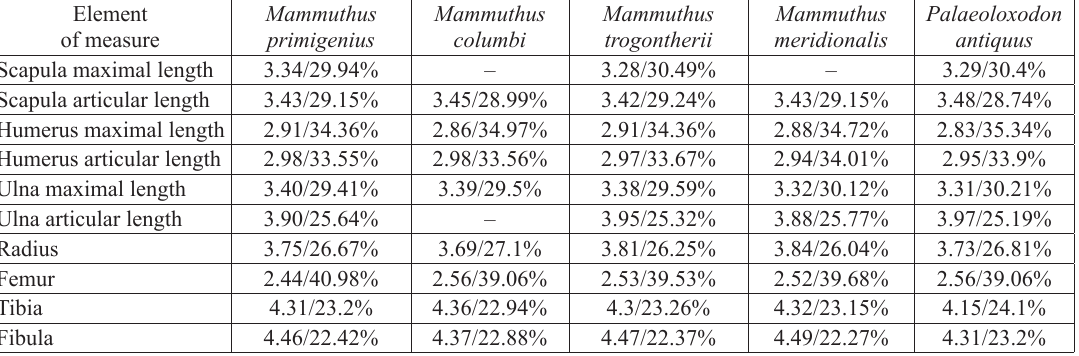
Table 3. Different proboscidean species ratios/percentages of different appendicular skeleton bone lengths vs. skeletal shoulder height. Element Mammuthus of measure primigenius antiquus Scapula maximal length Scapula articular length Humerus maximal length Humerus articular length 2.98/33.55% Ulna maximal length Ulna articular length 3.90/25.64%